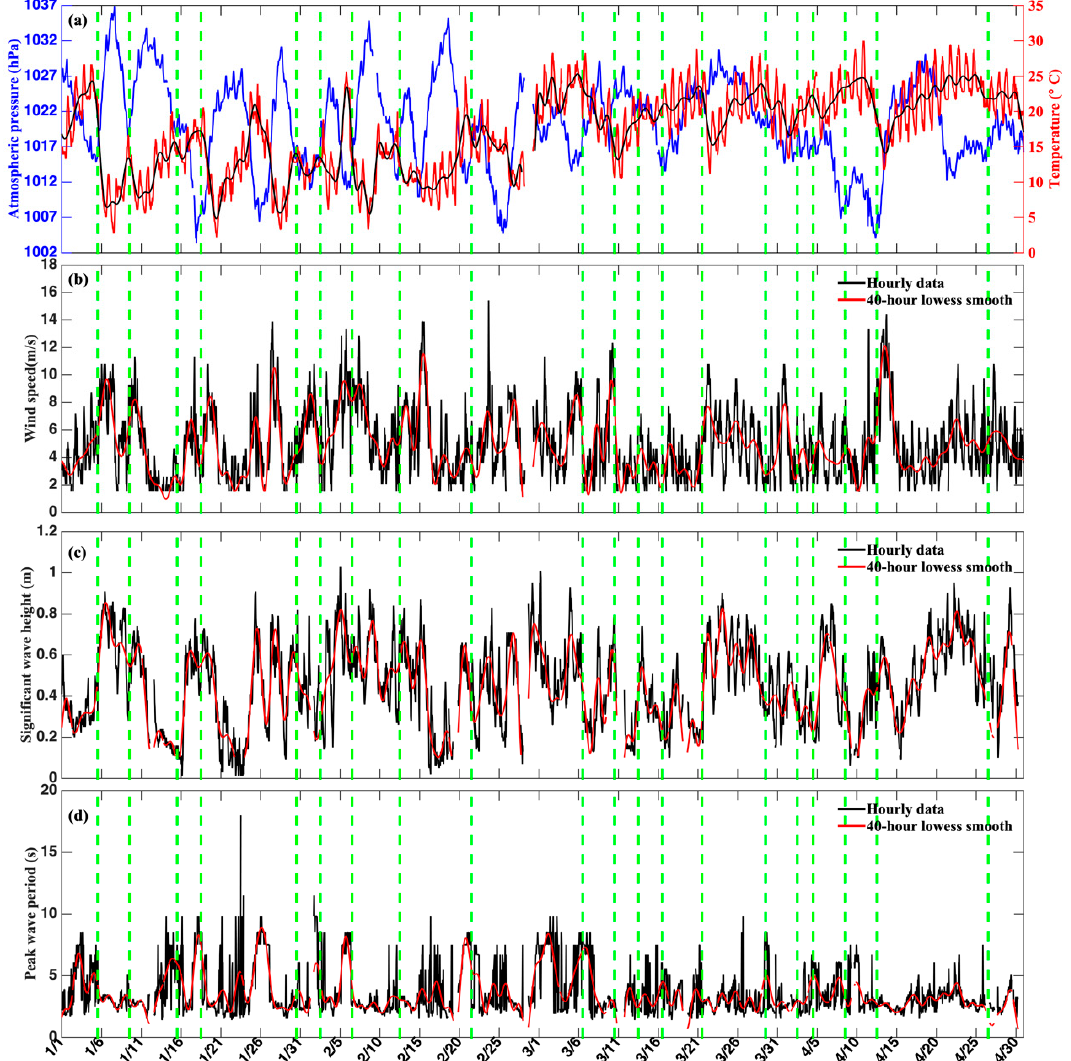
Figure 2. ( a ) Time series of the atmospheric pressure (blue line) and air temperature (red line) from the WS (30.0424° N, 90.0282° W) in Figure 1. The black line is the 40-h low pass filtered air temperature from January to April. ( b ) Wind speed (black line; unit: ms − 1 ) at WS, ( c ) significant wave height (black line; unit: m) and ( d ) peak wave period (black line; unit: s) at CSI 3 from January to April. The red line is the 40-h low pass filtered curve. The green vertical dashed lines indicate the timing of cold fronts.